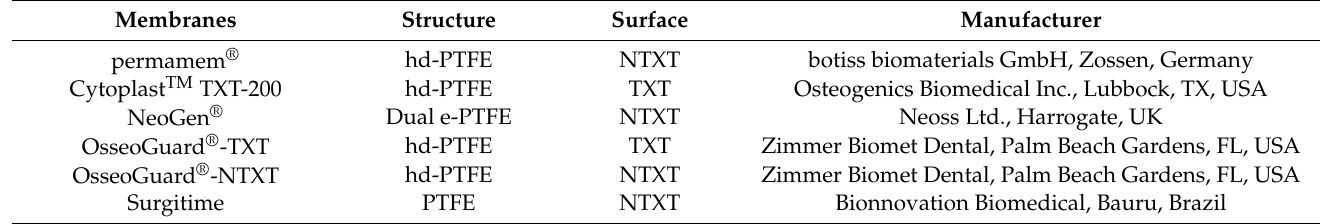
Table 1. Specifications of the used membranes as claimed by the manufacturers. Membranes Structure Surface Manufacturer permamem ® hd-PTFE NTXT Cytoplast TM TXT-200 hd-PTFE NeoGen ® Dual